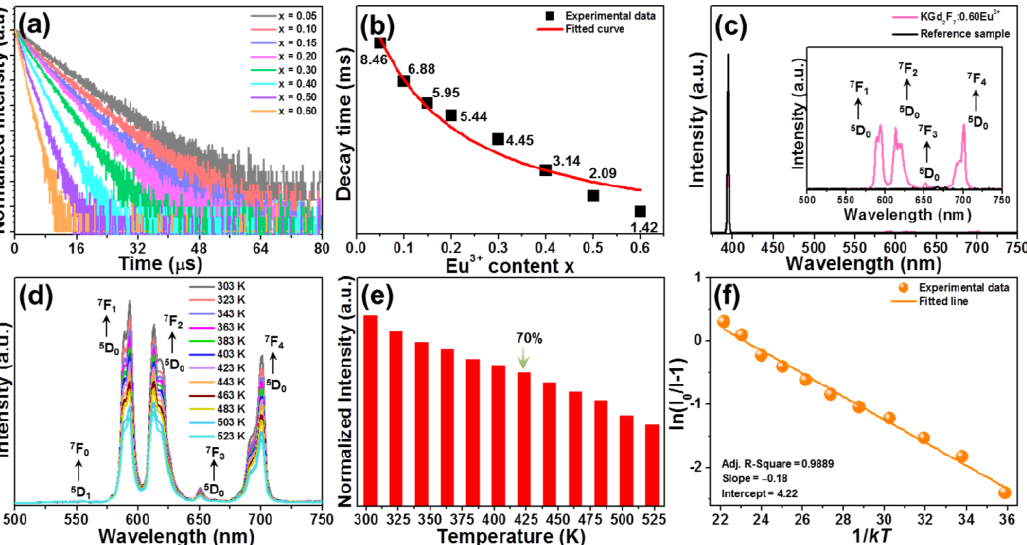
Figure 4. ( a ) Decay curves of KGd 2 F 7 :2 x Eu 3+ nanoparticles. ( b ) Lifetime of Eu 3+ as a function of dop- ing content. ( c ) Excitation profile of BaSO 4 reference sample and emission profile of KGd 2 F 7 :0.60Eu 3+ nanoparticles. ( d ) Emission spectra of KGd 2 F 7 :0.60Eu 3+ nanoparticles as a function of temperature. ( e ) Normalized emission intensity at diverse temperatures. ( f ) Plot of ln(I 0 /I − 1) vs . 1/ kT